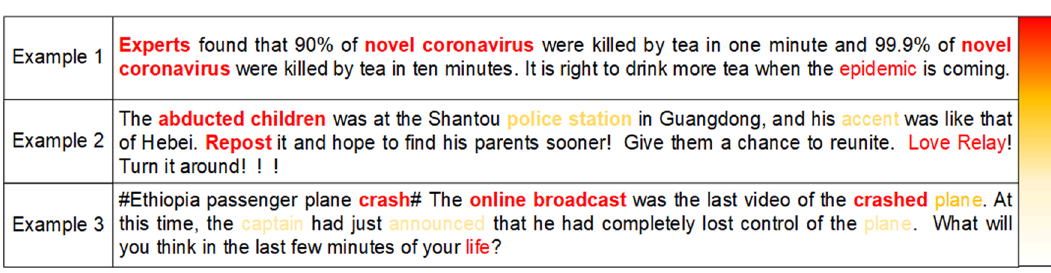
Figure 5. Visual analysis of the weights of key points for rumor